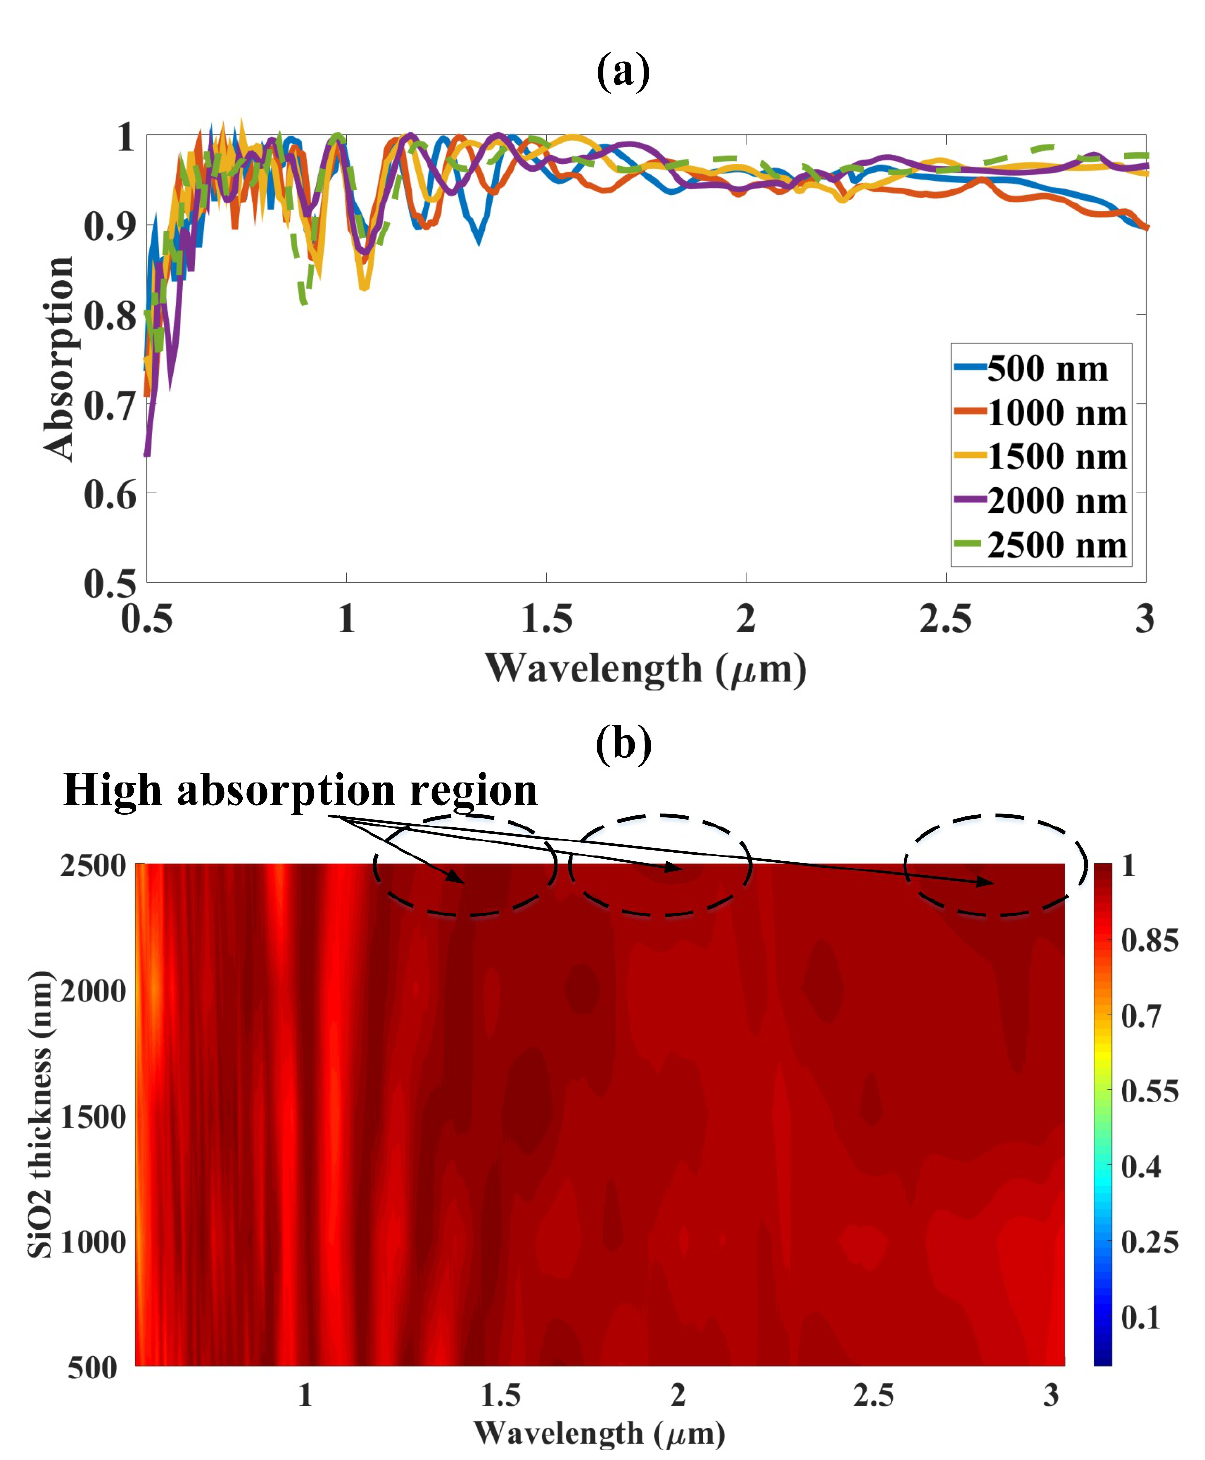
Figure 4. The impact of SiO 2 thickness change on absorption is shown in ( a ) the absorption response for 500 nm to 2500 nm SiO 2 thickness variation in a line plot and ( b ) the absorption response for 500 nm to 2500 nm variation in a color plot, with red having the highest absorption. The high absorption regions are marked in circles at 2500 nm. The high absorption is also visible in the line plot, with the green color line having a 2500 nm value.